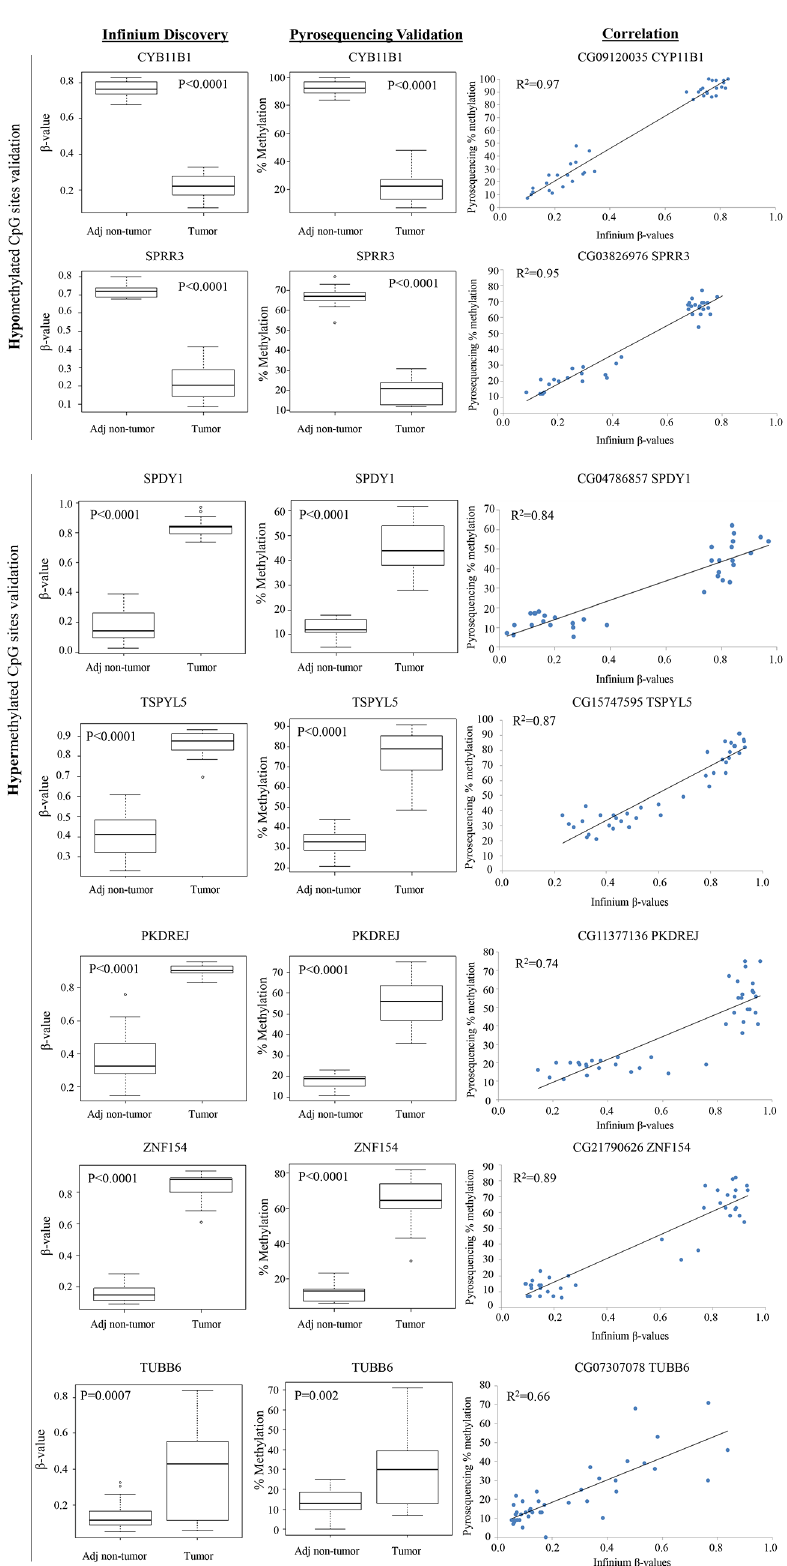
Figure 3. Validation of aberrantly methylated genes in tumors compared to adjacent non-tumorous tissues. Validation of methylation data was done using pyrosequencing. T-test was used to test the difference between tumors and adjacent non-tumorous tissues. Correlation between Infinium’s b -values and pyrosequencing’s percentage of methylation was measured using Pearson’s method. R 2 is the squared value of the Pearson correlation coefficient. doi:10.1371/journal.pone.0104158.g003 PLOS ONE |